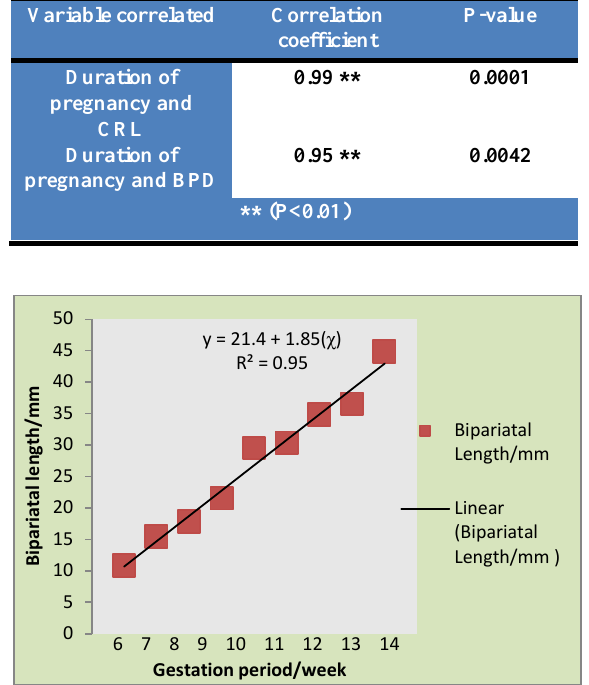
Figure, 10: Relationship between BPD (mm) and gestation age (week).